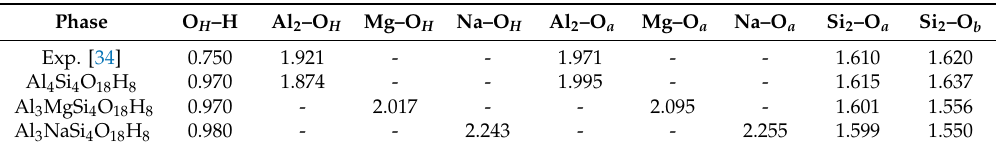
Table 2. Calculated vs. experimental average bond length of the undoped kaolinite (Al 4 Si 4 O 18 H 8